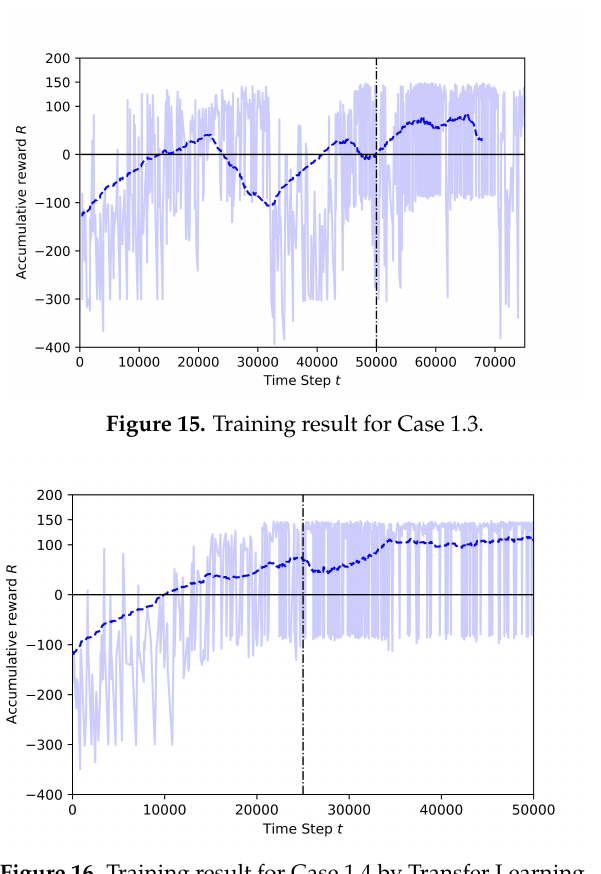
Figure 16. Training result for Case 1.4 by Transfer